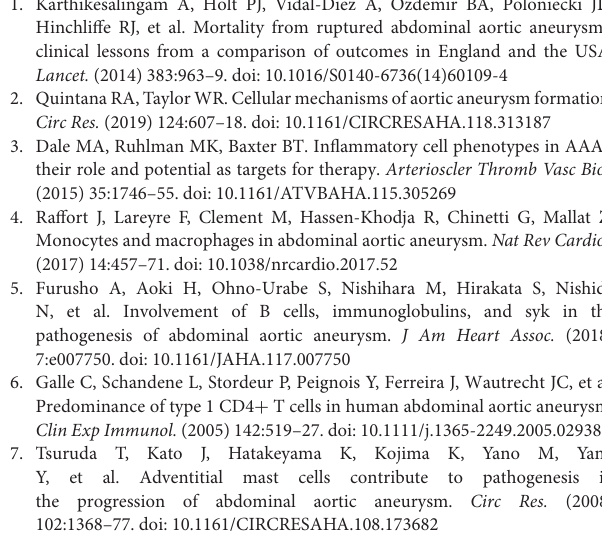
FIGURE 6 | ( ): n 5 for control mice and n 15 for Ang II-infusion mice]. (C) The incidence rate of AAA in control and Ang II-infused mice with or without fibrocytes + = = reconstitution. Fisher exact method was used to test for statistical significance. (D) Representative images of whole aortae. (E) Quantification of AAA diameter (mm). (F) Representative images of H&E staining of abdominal aortae. Scale bar 250 µ m. (G) Representative images of elastin staining in four groups of mice. Scale bar = 25 µ m. (H) Quantification of the elastin score. The quantitative data were shown as mean SEM, and the difference between multiple groups was evaluated by ± two-way ANOVA. * p < 0.05, ** p < 0.01, *** p < 0.001, and **** p < 0.0001. [Fibrocyte (–): n 5 for control mice and n 14 for Ang II-infusion mice; Fibrocyte ( = = 5 for control mice and n 13 for Ang II-infusion =